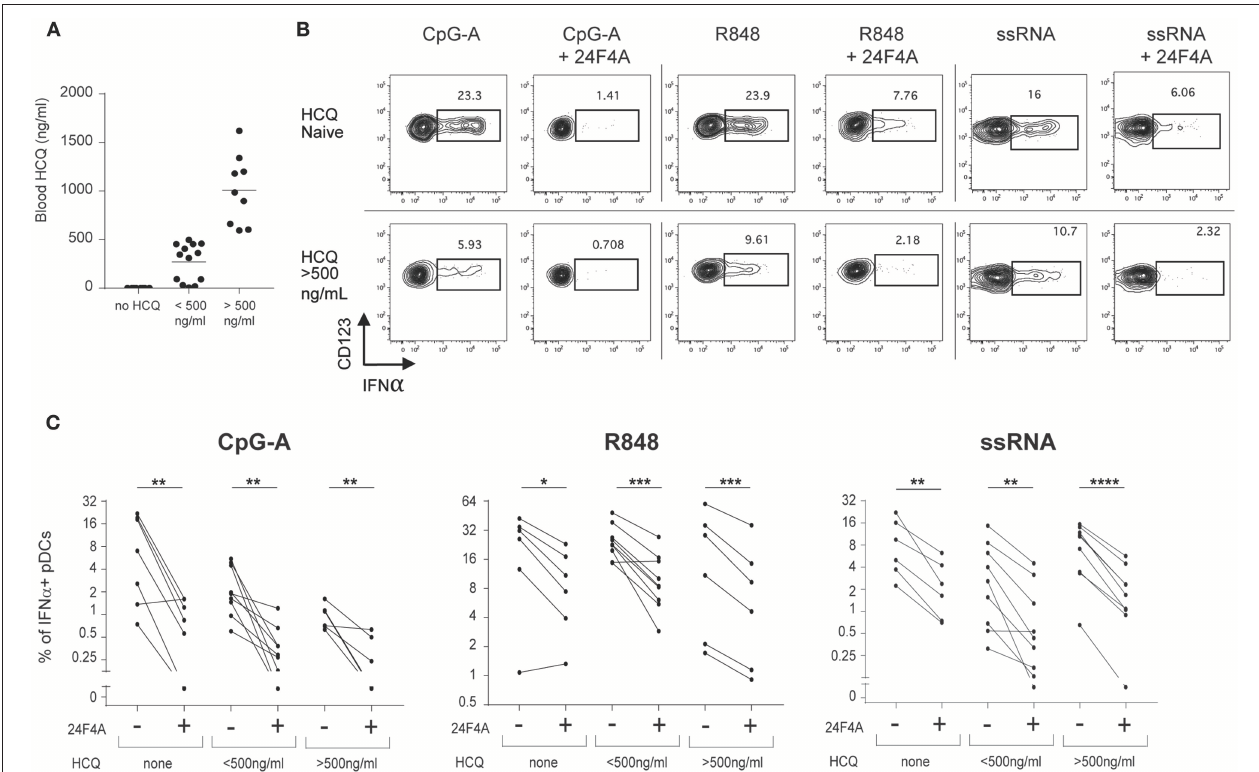
FIGURE 4 | 24F4A further reduces pDC IFN α production after CpG-A, R848 or ssRNA stimulations of PBMC isolated from CLE patients regardless blood HCQ levels. (A) Concentrations of HCQ in whole blood from the CLE patient cohort studied ( n = 30). (B) Representative dot plots of IFN α + cells within a BDCA4+ and CD123+ gate after CpG-A, R848 or ssRNA stimulation with or without pre-treatment with 24F4A (10 µ g/ml 30min) from CLE patient without detectable blood HCQ (top panel) or a CLE patient with a blood HCQ concentration of more than 500ng/ml (bottom panel). (C) Effect of 24F4A on the percentage of IFN α -producing pDCs induced by CpG-A, R848 and ssRNA stimulations and detected by flow cytometry in PBMC from CLE patients without detectable level of blood HCQ ( n ≥ 6 donors), with blood HCQ concentrations lower than 500ng/ml ( n ≥ 8 donors) or > 500ng/ml ( n ≥ 6 donors). Statistical significance was assessed with a two-tailed paired Student’s t-test using log2-transformed values (* p < 0.05, ** p < 0.01, *** p < 0.001, **** p <